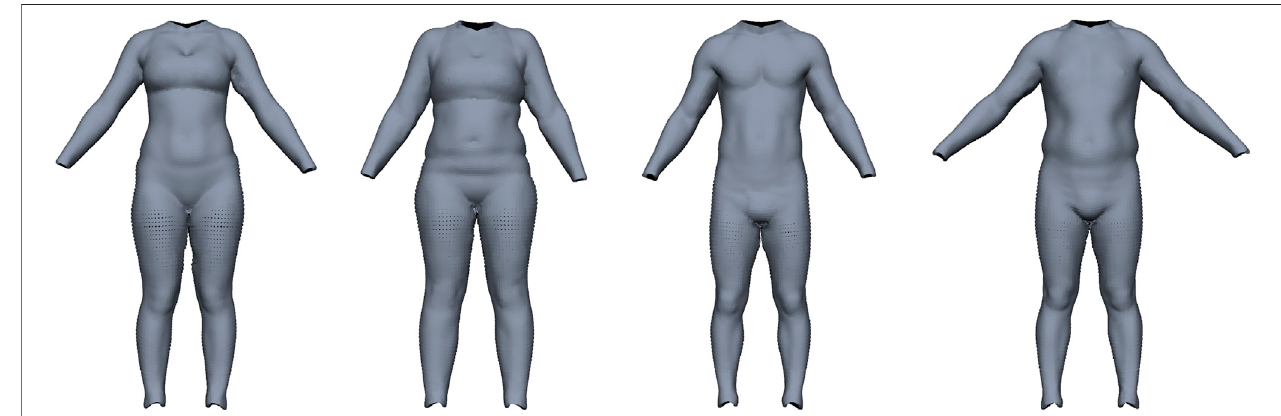
FIGURE 5 | Examples for the BeyondBMI dataset provided by Maalin et al. (2020) consisting of scans of 100 men and 100 women, annotated with fat mass, muscle mass, and BMI. The scans lack geometric data for head, hands, and feet and are captured in approximate A-pose (with noticeable variation in pose).